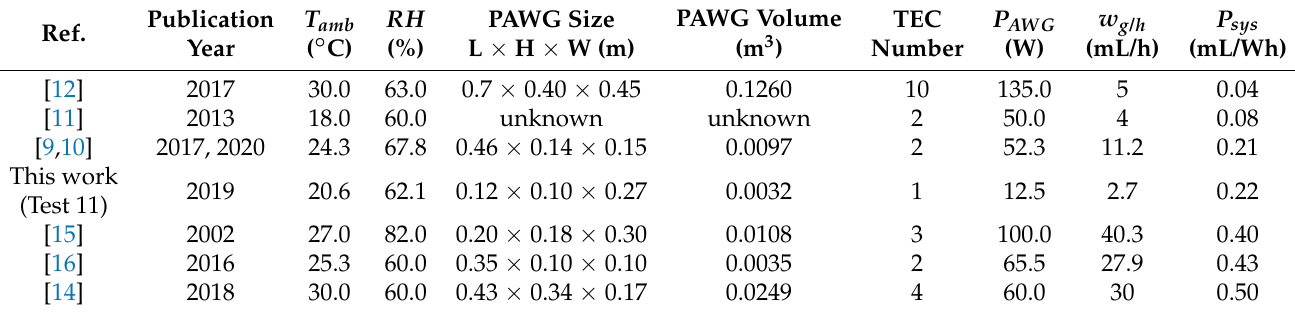
Table 4. Comparison with other PAWG